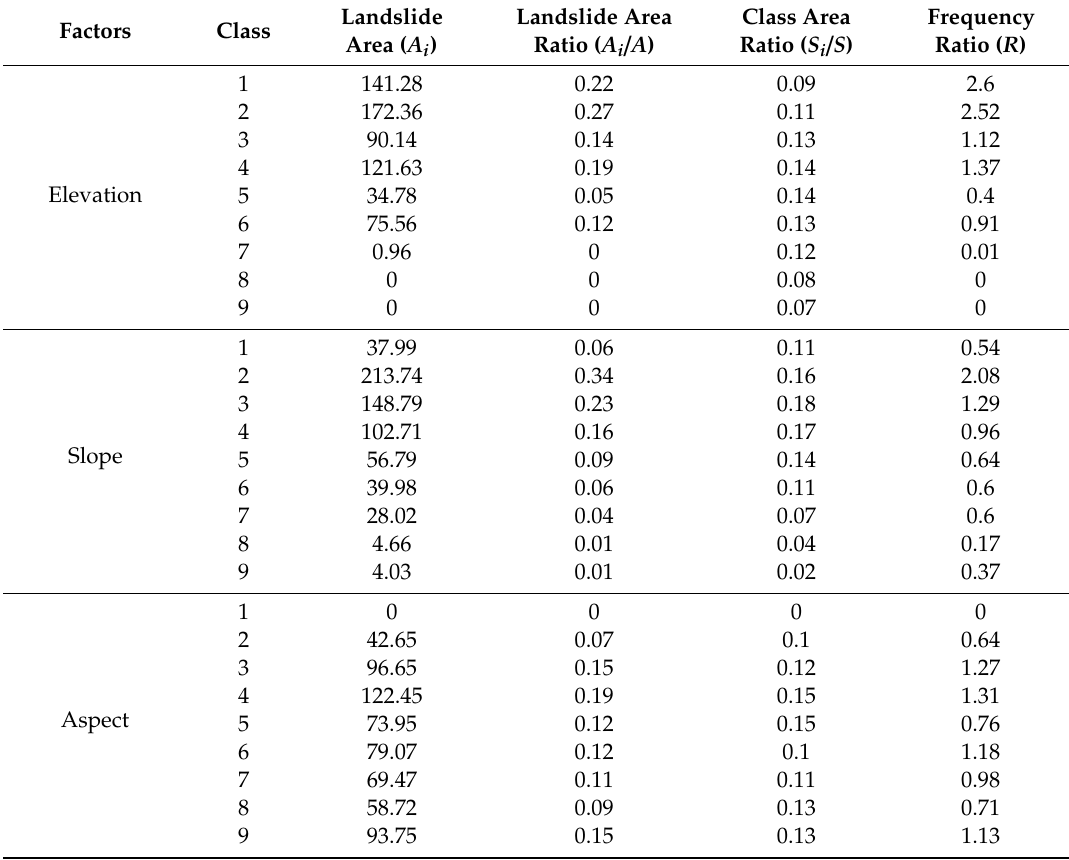
Table 1. The R values for the classes of the landslide predisposing factors. Factors